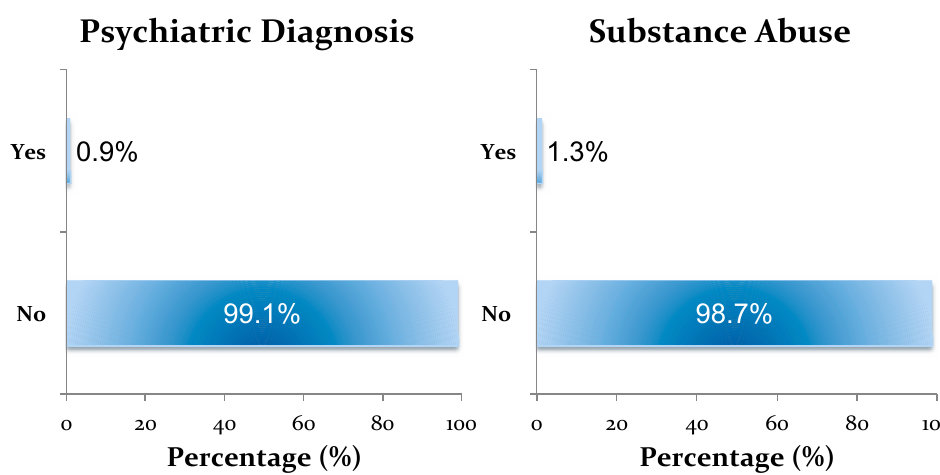
Figure A4. ( Left ) % of participants with and without psychiatric disorders; ( Right ) % of participants with and without psychiatric disorders.